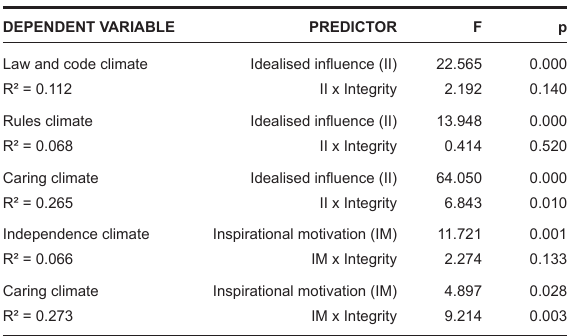
TABLE 3 Regression of an ethical climate on transformational leadership and the interaction between the dimensions of transformational leadership and